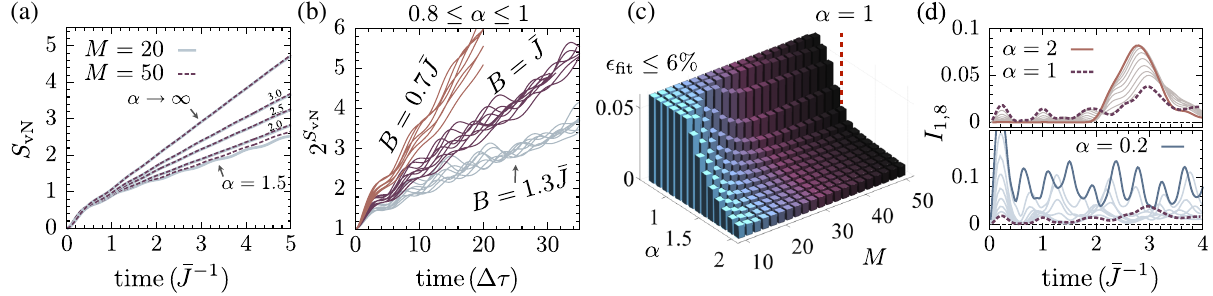
FIG. 3. Entanglement growth after a quantum quench in the transverse Ising model in which algebraically decaying interactions are introduced suddenly. (a) Time evolution of the half-chain entropy after the quench for B ¼ 1 and varying decay exponents (cid:1) ¼ 1 : 5 , 2, 2.5, 3, and 1 (from bottom to top). Solid lines are ED results for M ¼ 20 spins; dashed lines are MPS/MPO results for 50 spins (converged with MPS bond dimension D ¼ 192 ). For (cid:1) (cid:4) 2 , the growth is clearly linear and independent of the system size. (b) Time evolution of 2 S vN . Each of the three bundles of lines contains the results for M ¼ 30 , 40, and 50 spins and (cid:1) ¼ 0 : 8 , 0.9, and 1 (MPS/ MPO simulation, converged with D ¼ 192 ). On top of the oscillations, the growth is logarithmic (straight line on the exponential scale). Time is given in units of the inverse Hamiltonian norm, (cid:2) (cid:9) (cf. Sec. III B 1). (c) Finite-size scaling of the crossover from linear S growth to a logarithmic one visualized by the error of a linear fit, (cid:5) , in the interval 1 < t (cid:1) J < 3 as a function of (cid:1) and M ( B ¼ 1 , vN fit ED and MPS/MPO simulations, D ¼ 192 ). For large systems, the crossover occurs around (cid:1) (cid:3) 1 . (d) Time evolution of the mutual ( M ¼ 20 , B ¼ (cid:1) J , ED). The upper panel shows results for 2 (cid:4) (cid:1) (cid:4) 1 , the lower panel for information between spins 1 and 8, I 1 ; 8 1 (cid:4) (cid:1) (cid:4) 0 : 2 . The signature of linear growth of the half-chain entropy is the arrival of a quasiparticle peak after a certain time, whereas for (cid:1) & 1 , distant spins become entangled